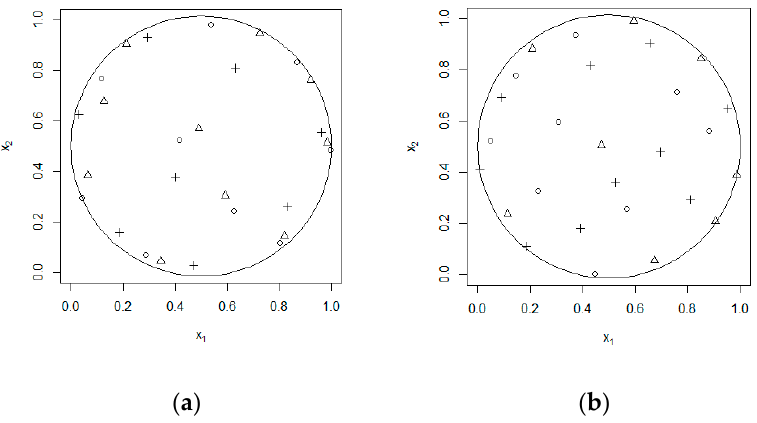
Figure 4. Dimensional mapping scatter plots of the designs: ( a ) FFF, n = 27; ( b ) MP-CE, n = 27.